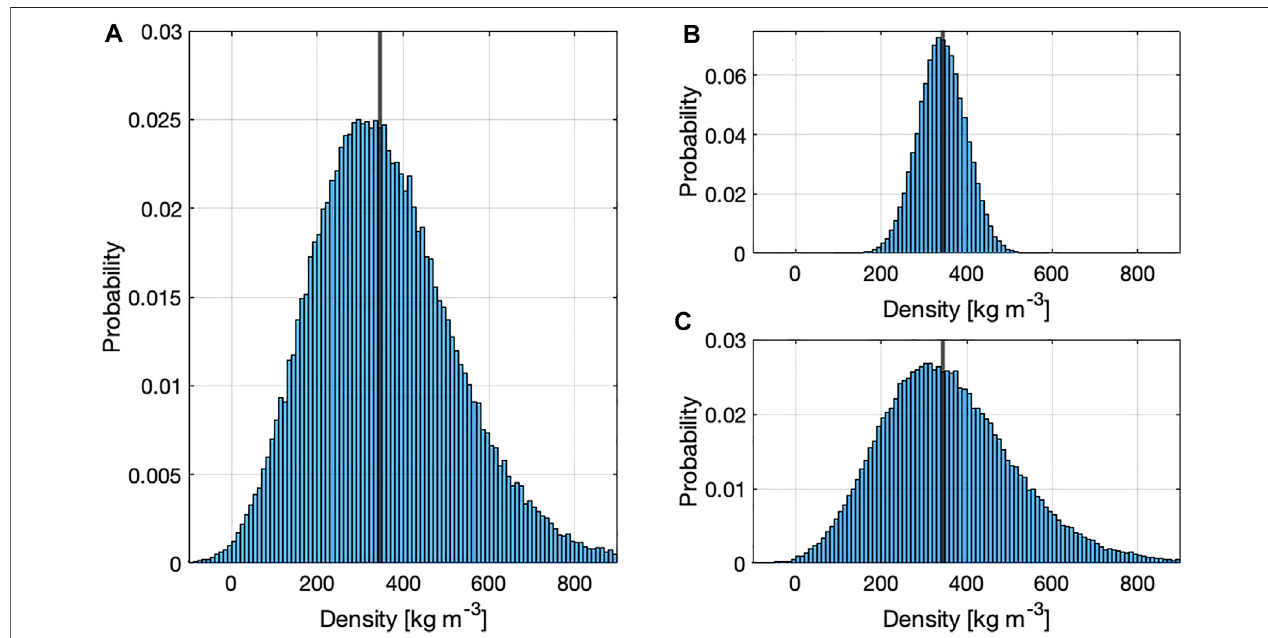
FIGURE 8 | (A) Snow densities from a Monte Carlo analysis of uncertainty in SfM-derived snow depths and GPR-measured twt . Black vertical line in all subplots indicates the “ true ” density of 345 kg m − 3 (B) Identical analysis but limiting uncertainty to twt . (C) Identical analysis but limiting uncertainty to snow depth.